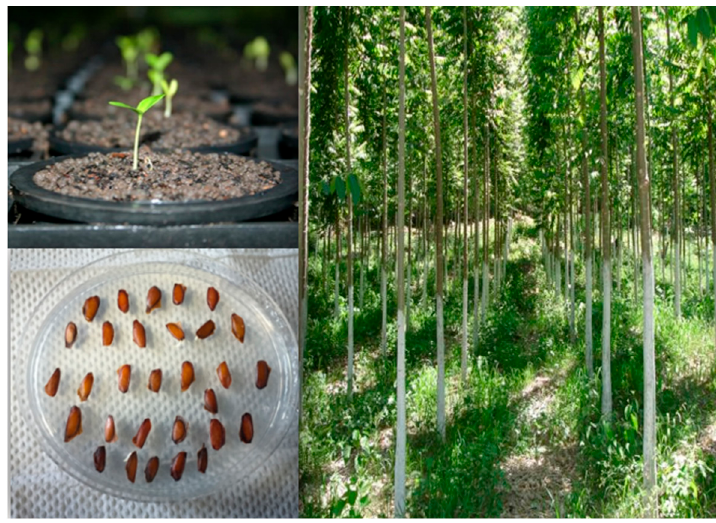
Figure 4. Seeds, seedlings, and young trees of C. odorata .